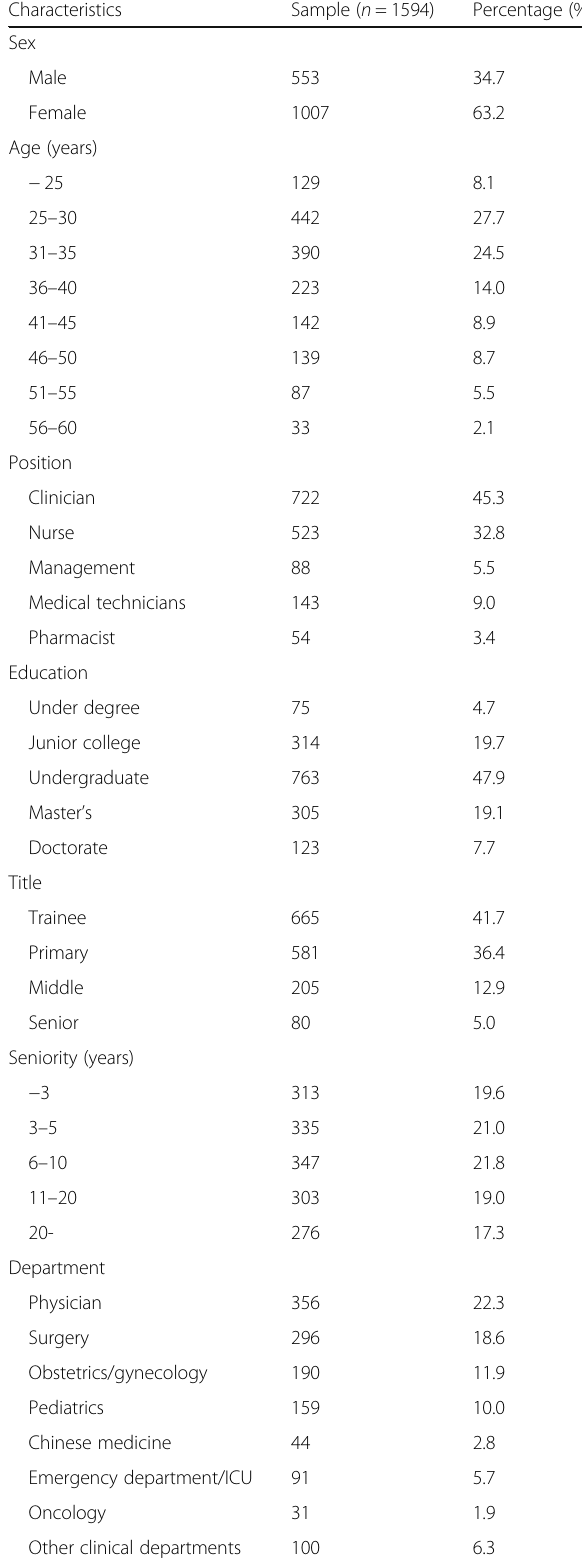
Table 1 Demographic characteristics of the sample Characteristics